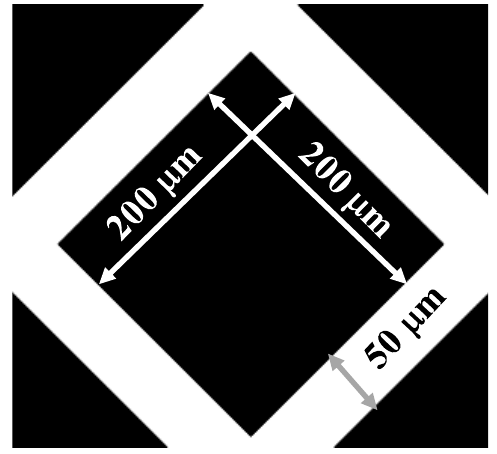
Figure 2. Geometry of a square unit cell on the screen.